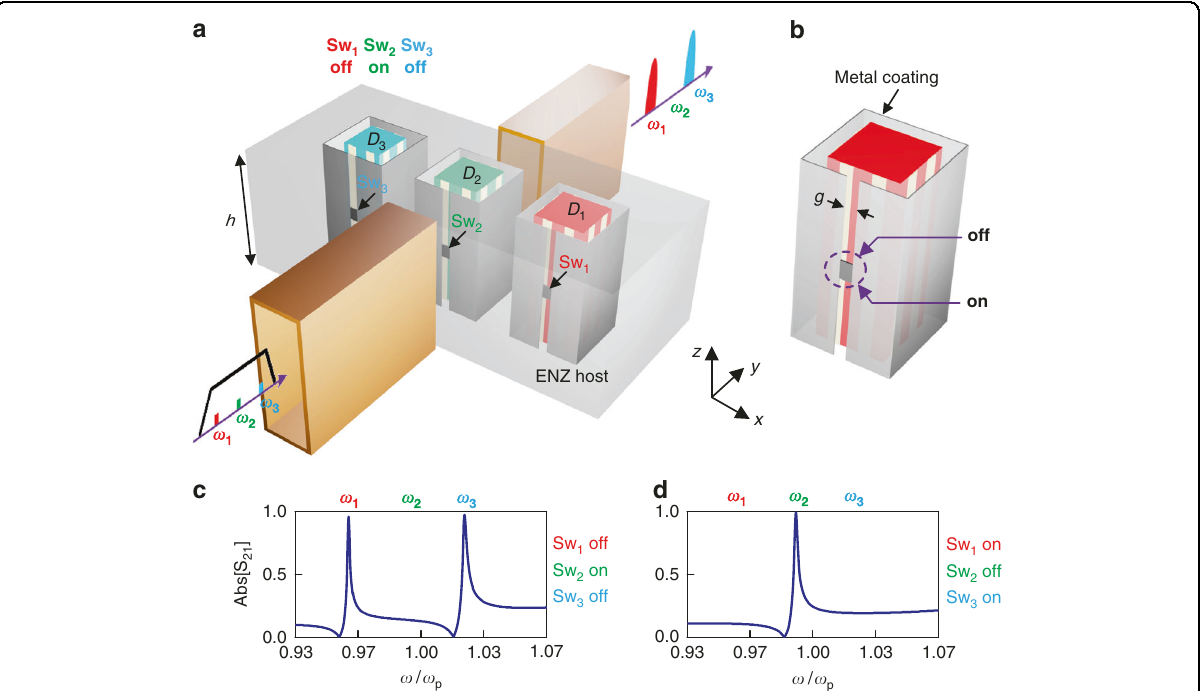
Fig. 5 Multi-frequency dynamic fi ltering. a The architecture and working principle of the proposed three channel dynamic fi lter, where multiple dopants controlled by switches independently govern narrow channels at angular frequencies ω 1 , ω 2 , and ω 3 . The metallic cavity is designed with a height h of 0.5 λ p ( λ p is the free-space wavelength at ω p = 2 π × 3 × 10 9 rad/s). Side lengths of square cross-sections of the dopants D 1 , D 2 , and D 3 are 0.112 λ p , 0.106 λ p , and 0.097 λ p , respectively. The metallic side walls of the doped cavity are not shown here. ( b ) Con fi guration of a photonic dopant assembled with a switch. ( c ) and ( d ) are the simulation results for the transmitting spectra under different states of the